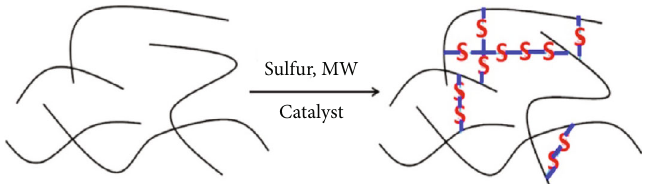
Figure 18: Reaction scheme of the rubber